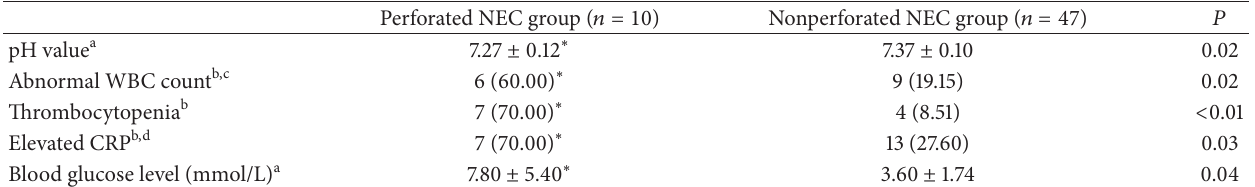
Table 3: Comparison of laboratory tests in NEC infants with and without bowel